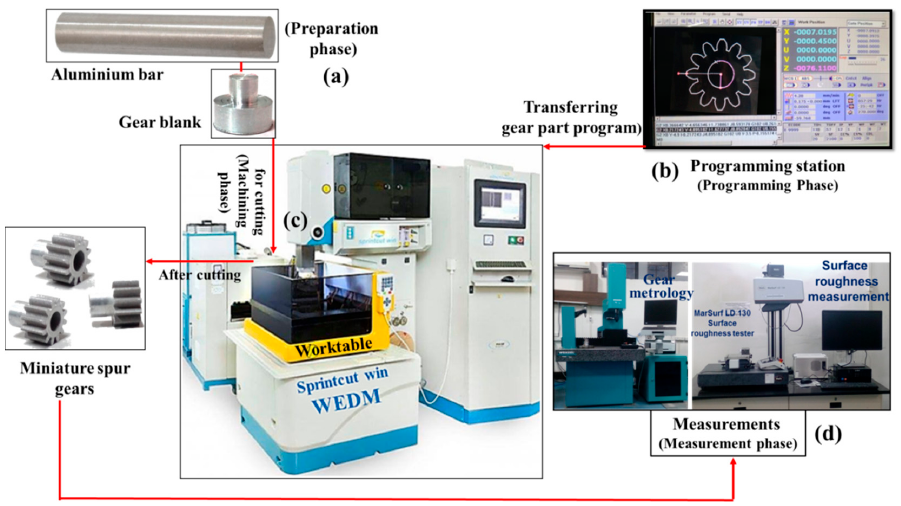
Figure 2. Process sequence or different phases involved to manufacture miniature spur gear with bore and hub by wire-assisted thermoelectric erosion machining: ( a ) preparation phase; ( b ) programming phase; ( c ) machining phase; and ( d ) measurement phase.